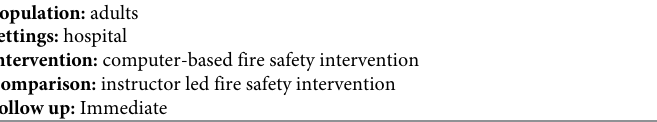
Home fire safety behaviour. Two studies were pooled to assess the effects of interventions (Risk Watch and Great Escape) vs no interventions on home fire safety behaviour at short- term (up to 4 months) follow up. The pooled results, displayed no significant difference between groups (very low quality, 2 RCTs, 609 participants, SMD 0.34, 95% CI: -0.21 to 0.89, p = 0.23, Fig 3; Analysis 1.1.2). Heterogeneity was high, and we were not powered to conduct sub-group analysis. Given the MCID of 0.5 SD, the pooled results were not clinically impor- tant. However, more data are required to make a definitive conclusion.